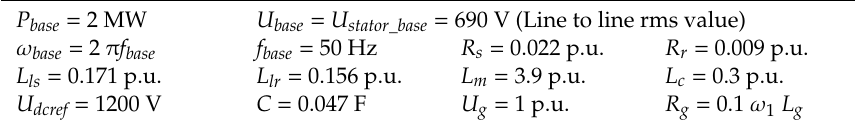
Table A1. 2 MW DFIG parameters.